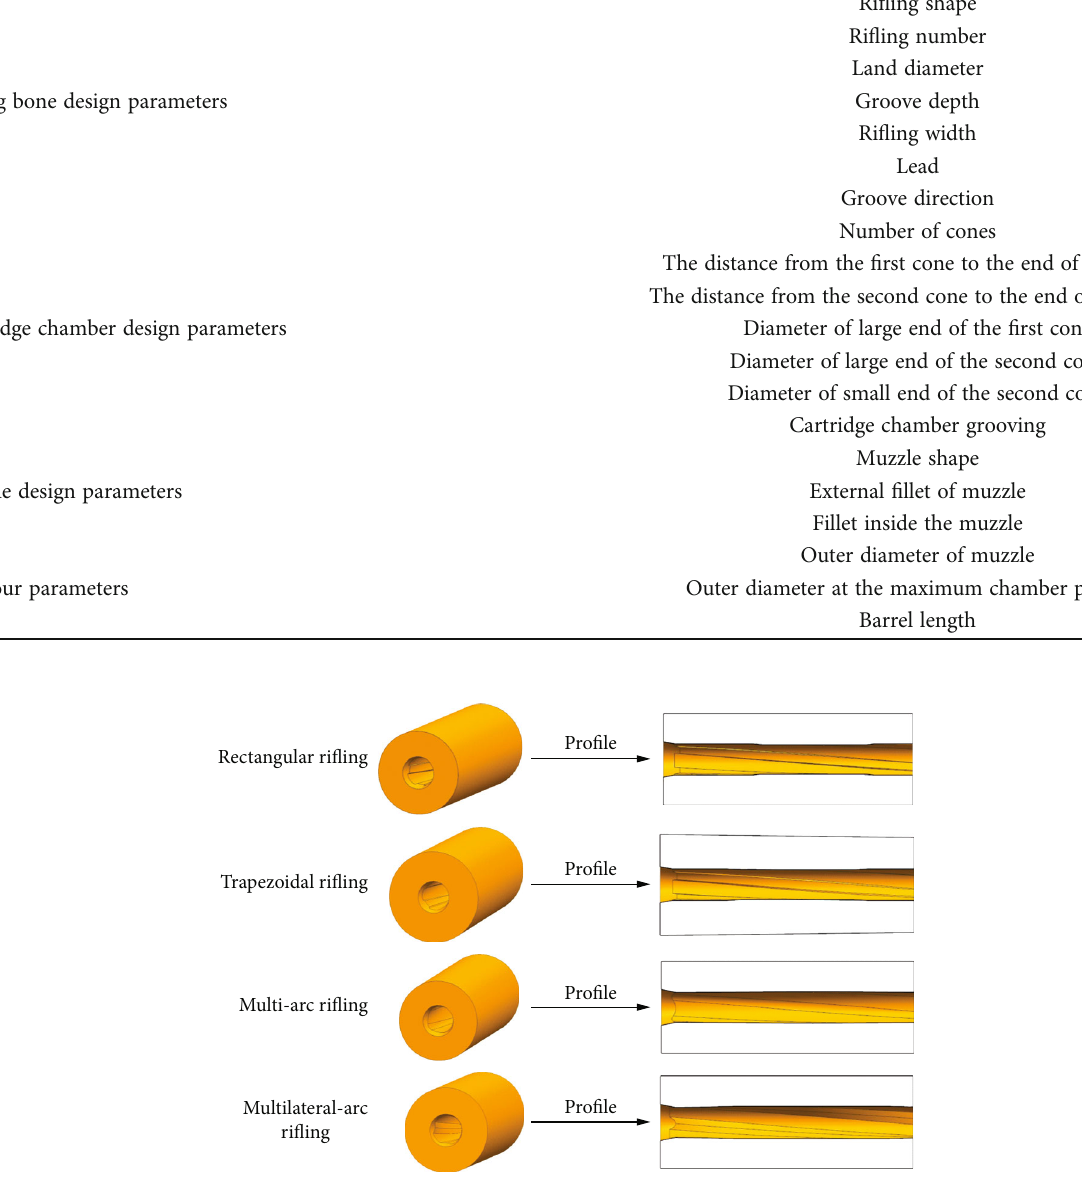
Figure 2: Parametrized template for barrels with di ff erent ri fl ing section